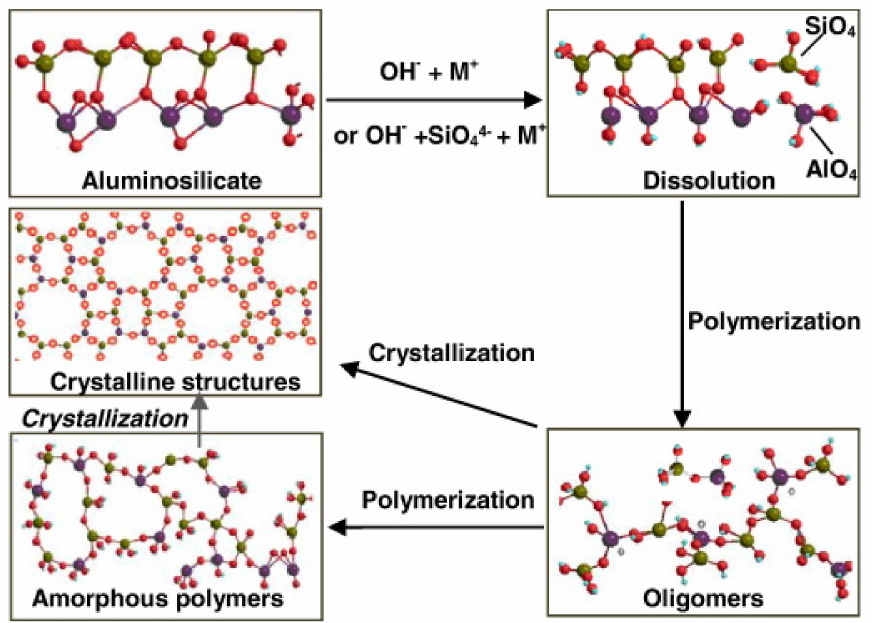
Figure 3. Zhang model of the geopolymerization process. Reprinted with permission from ref. [40]. Copyright 2016